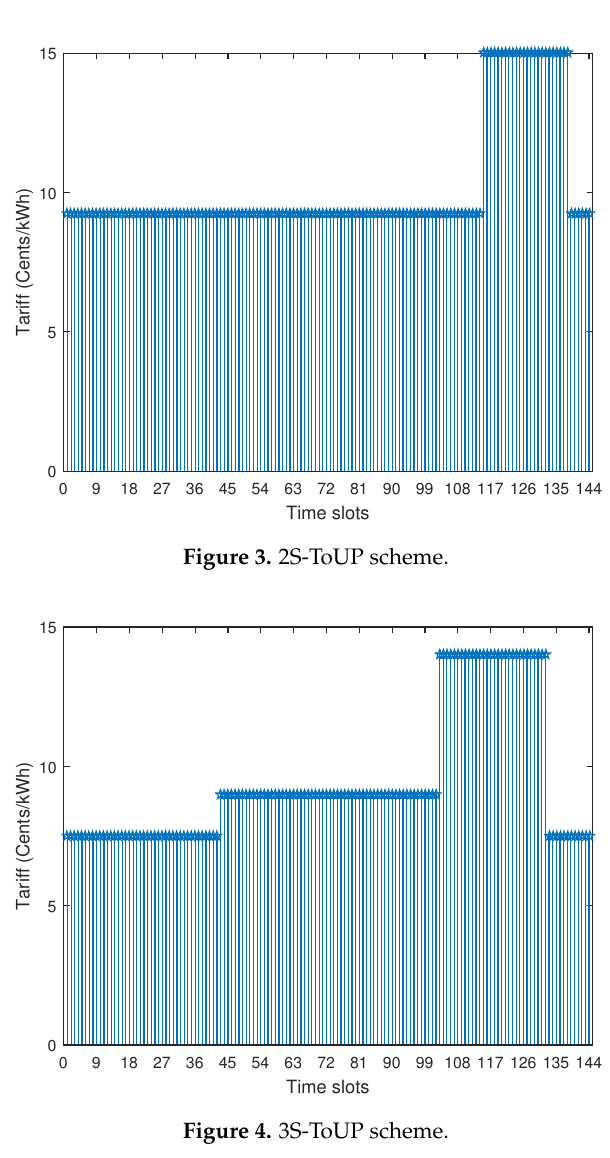
Figure 4. 3S-ToUP